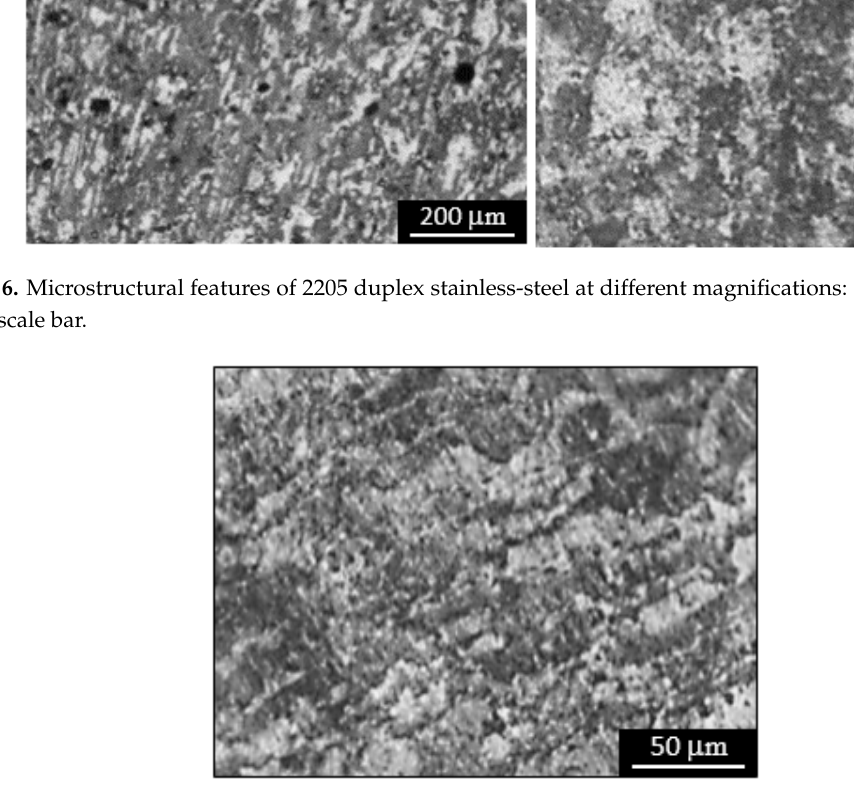
Figure 7. Microstructure images of welded joint.